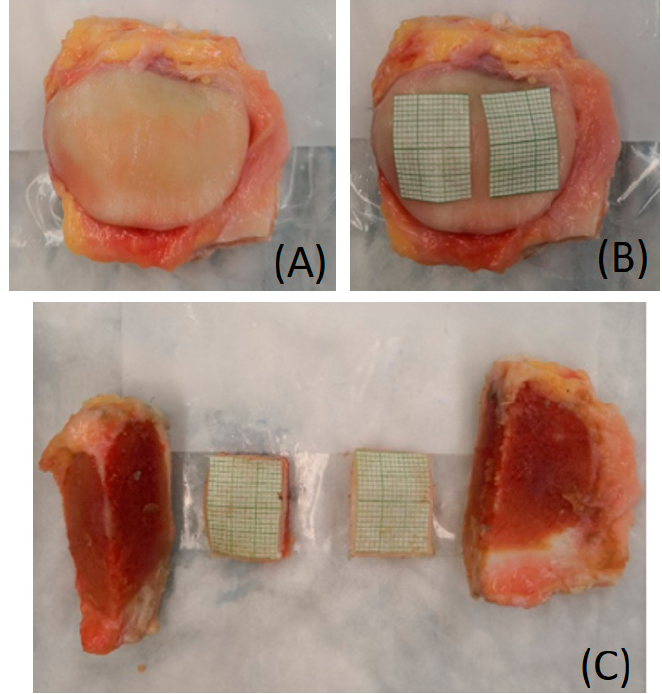
Figure 2. Steps for sample preparation of the patella cartilage; Patella was thawed from a freshly frozen condition (A). Two sheets with a grid of 15 mm × 20 mm were placed on the surface of the patella to create a template (B). Two 15 mm × 20 mm specimens were prepared from each patella (C).